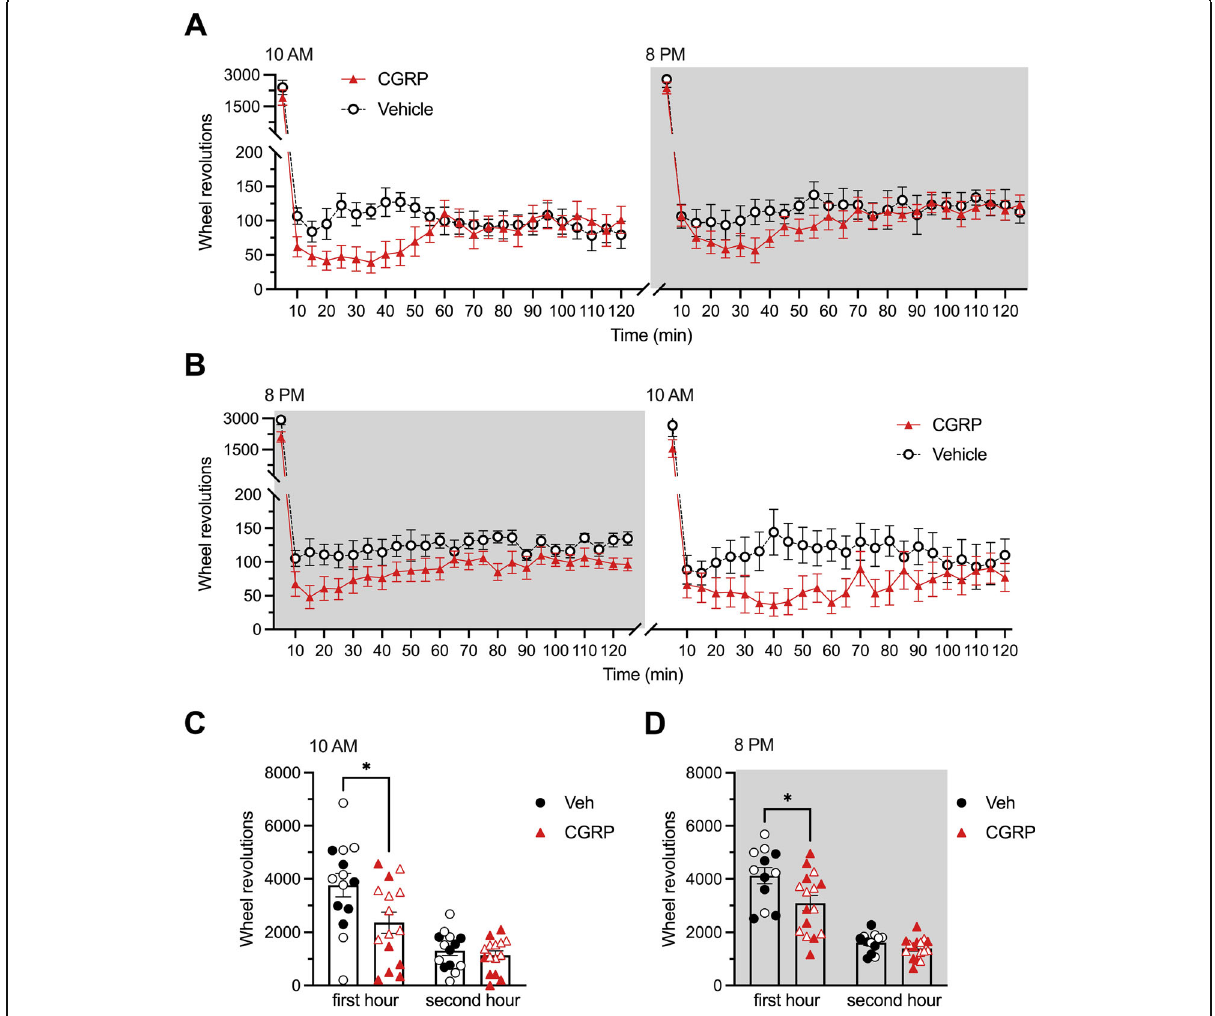
Fig. 2 Peripheral CGRP administration depresses wheel activity during both the inactive and active phases. In all panels, grey areas represent the active phase of the animals when lights of the facility were turned off (night). Empty symbols represent females, and full symbols represent males. There were no statistical differences between males and females. Number of wheel revolutions by CD1 mice was measured for 2 h starting immediately after treatment administration. A The first cohort of mice was tested at 10 AM first, then at 8 PM a week later. Animals were administered with vehicle (PBS, i.p., n = 7) or CGRP (0.1 mg/kg i.p., n = 8) before being placed in the wheels. B The second cohort of mice was tested at 8 PM first, then at 10 AM a week later. Animals were administered with vehicle (PBS, i.p., n = 7) or CGRP (0.1 mg/kg i.p., n = 8) before being placed in the wheels. C Data accumulated at 10 AM from the two cohorts in A and B was pooled together and analyzed per hour. D Data accumulated at 8 PM from the two cohorts in A and B was pooled together and analyzed per hour. Two-way (factors: time x treatment) ANOVA (interaction and treatment factors ns) for panels A and B (underpowered). Unpaired t-test (* p < 0.05) for panels C and